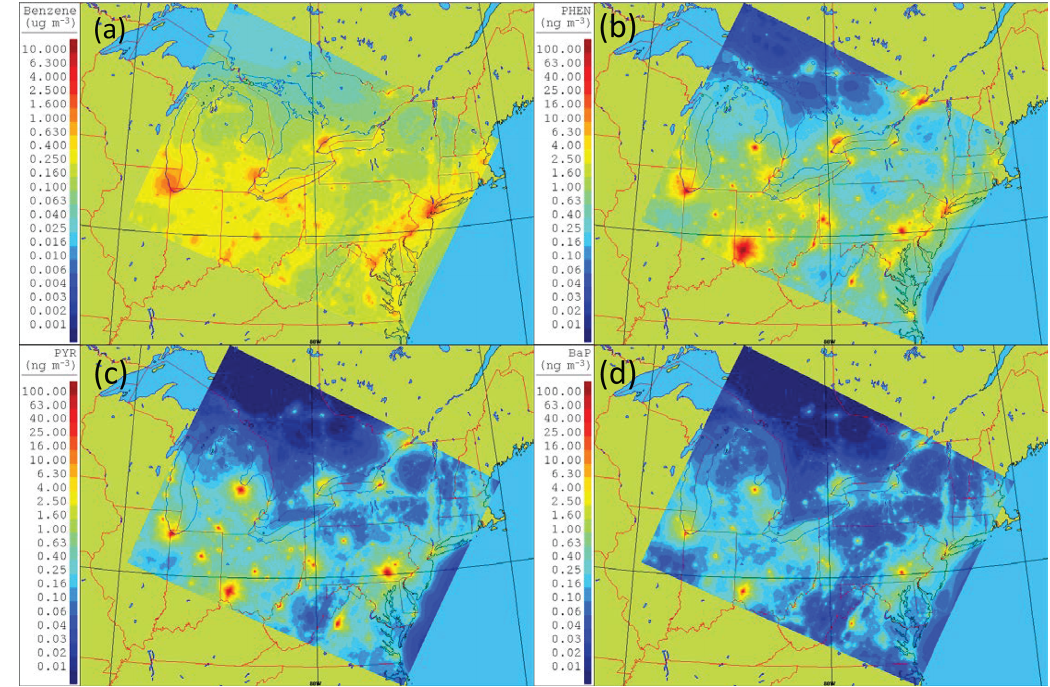
Figure 2. Modelled average airborne concentrations for (a) BENZ, (b) PHEN, (c) PYR, and (d) BaP in the spring–summer.